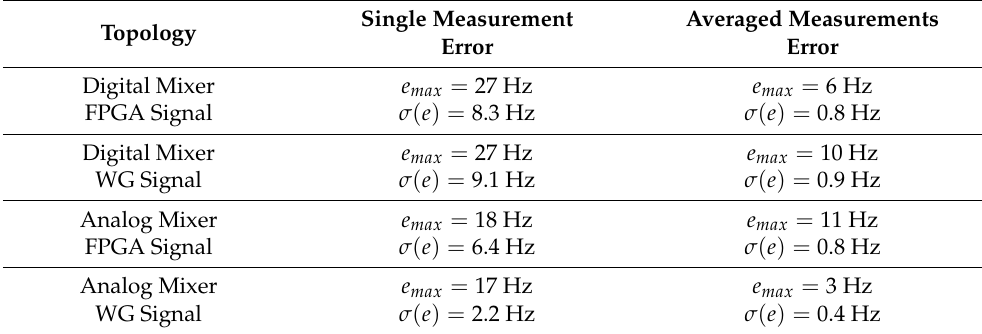
Table 1. Quartz mixing signal topologies comparison in terms of maximum error and error standard deviation performing a single measurement on the frequency meter input signal and averaging 100 repeated measurements performed on each frequency.